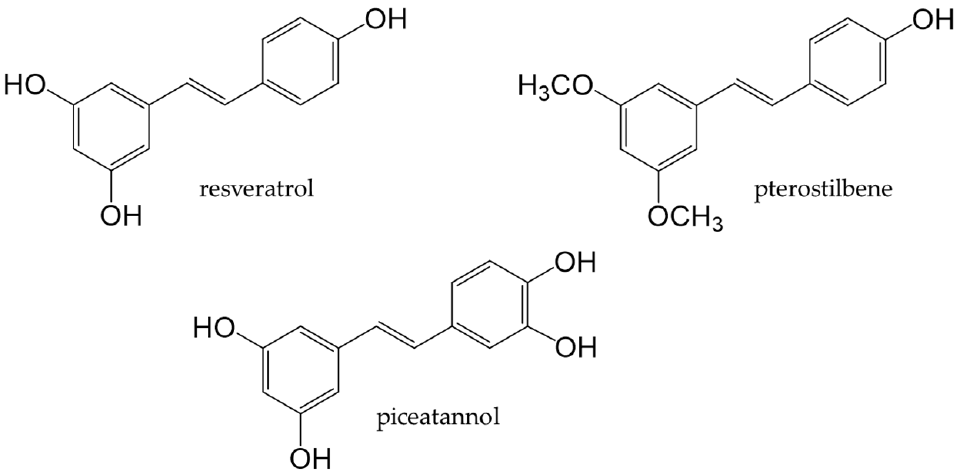
Figure 13. Chemical structures of major stilbenoids.